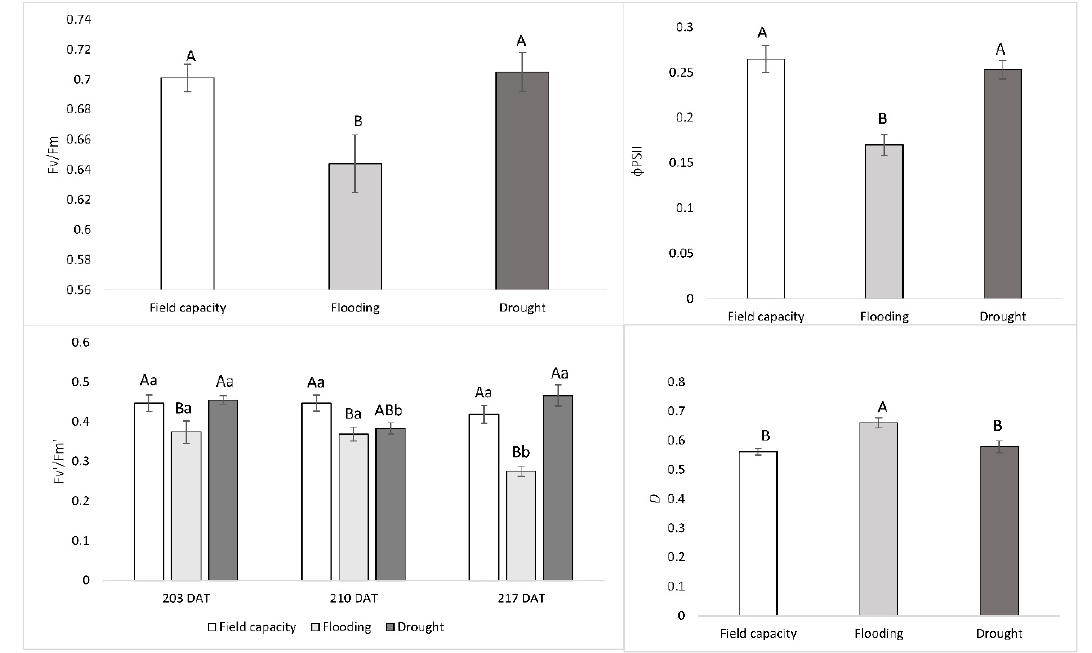
Figure 5. Maximum quantum yield (Fv/Fm), potential quantum efficiency (Fv ′ /Fm ′ ), effective quantum yield ( ф PSII) and energy dissipated in the form of heat ( D ) in Annona crassiflora plants kept under Field capacity ( − 0.01 MPa), Flooding and Drought ( − 1.5 MPa) conditions at 5, 10 and 18 days after the application of treatments, respectively, at 168, 173 and 178 days after transplanting. Uppercase letters indicate significant differences among treatments; lowercase letters indicate differences among times ( p < 0.05).